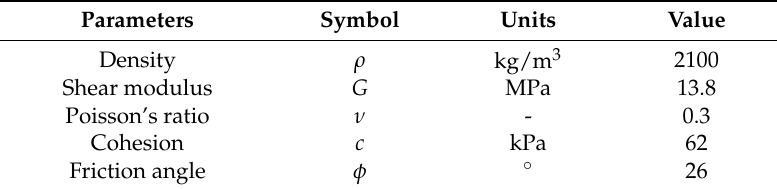
Table 5. Material properties of the soil mass.